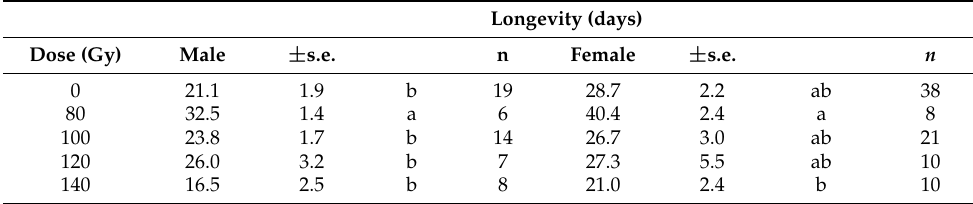
Table 5. Longevity (mean ± s.e.) of irradiated Bagrada hilaris males and females at high doses (80 Gy upwards) compared with the untreated control. Analysis of Log-rank (Mantel–Cox) was performed for mean separation. Means followed by different letters are significantly different between them. Longevity (days) Dose (Gy) ±